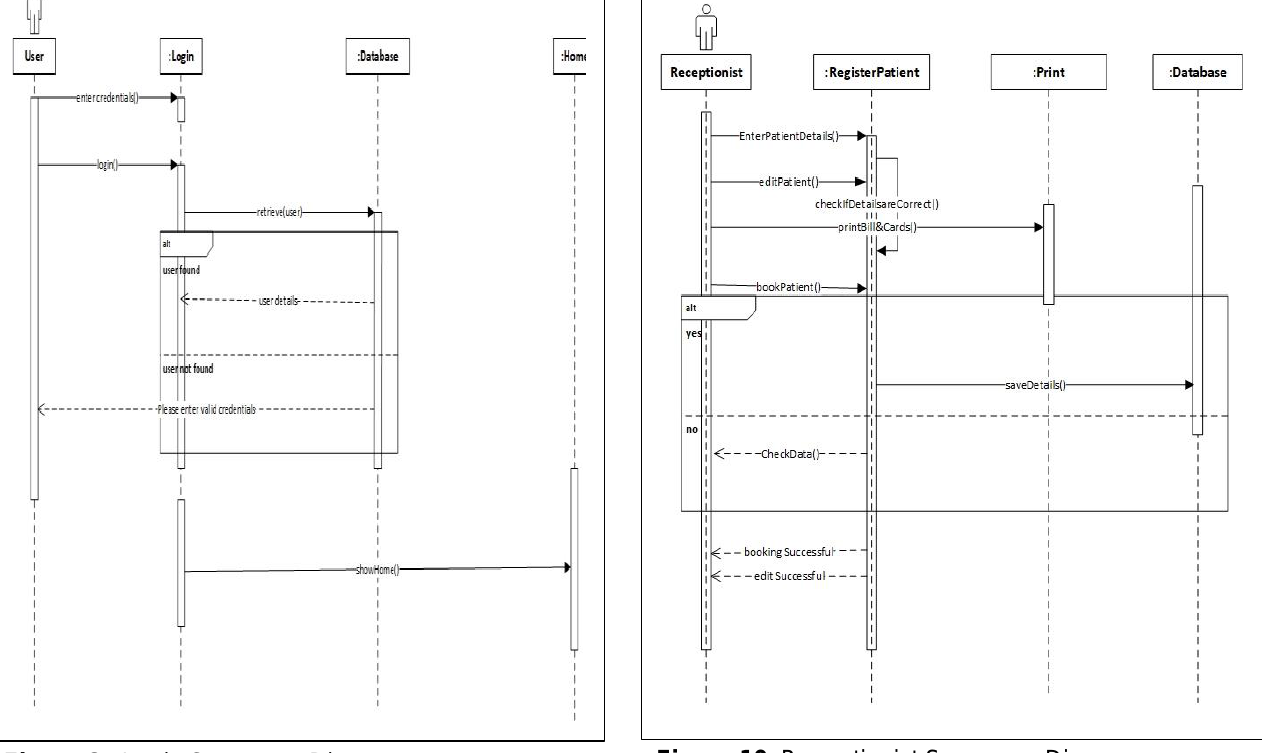
Figure 8. Login Sequence Diagram